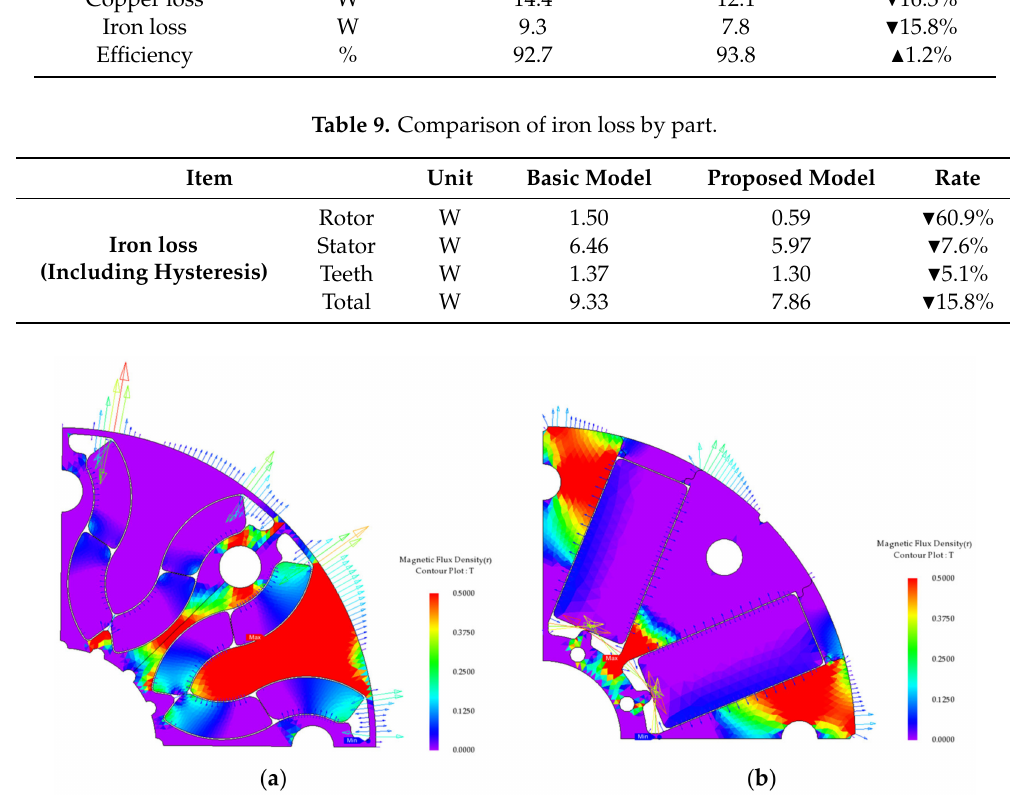
Figure 16. Comparison of the flux density at the load condition: ( a ) flux density of proposed flared type rotor; ( b ) flux density of basic spoke type